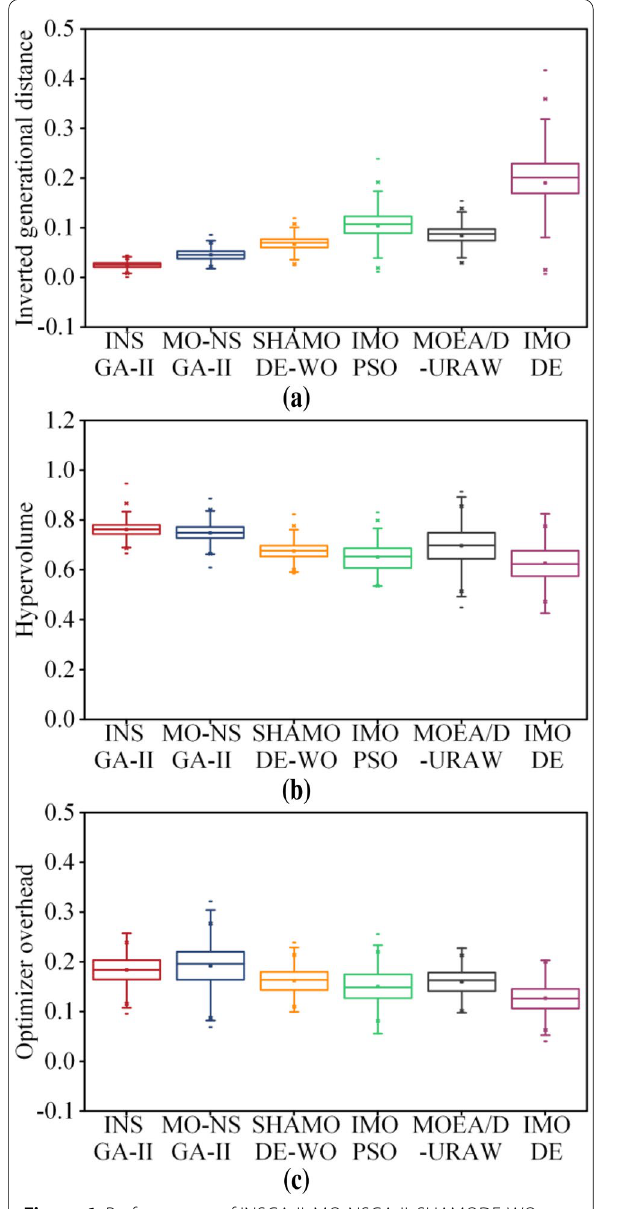
Figure 6 Performances of INSGA-II, MO-NSGA-II, SHAMODE-WO, IMOPSO, MOEA/D-URAW and IMODE in optimizing the problem of HRRA trajectory planning: ( a ) IGD, ( b ) HV, ( c ) OO